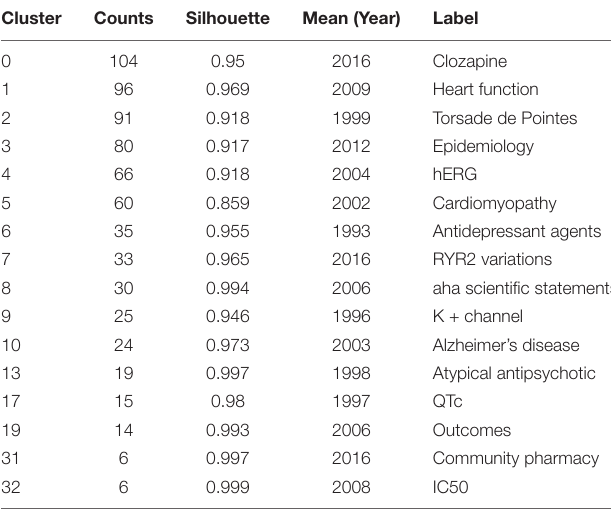
TABLE 2 | Statistics of different clusters in Figure 4A .